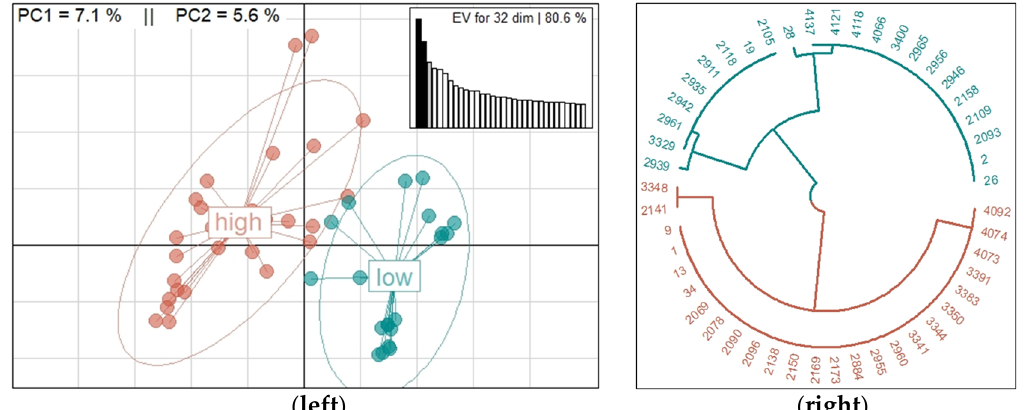
Figure 1. Graphic representation of the principal components analysis (PCA; ( left )) and dendrogram built from Euclidian distances ( right ). Both representations show the subpopulations of Katahdin ewes in agreement with their level of fecundity (high or low). For the PCA, the Eigenvalues (EV) of 32 dimensions are shown whose sum of variances is equal to 80.6%, in addition to the variance explained by the first (PC1) and second (PC2) dimension. Table 1. Information of detected runs of homozygosity (ROH) in the genome of Katahdin sheep.